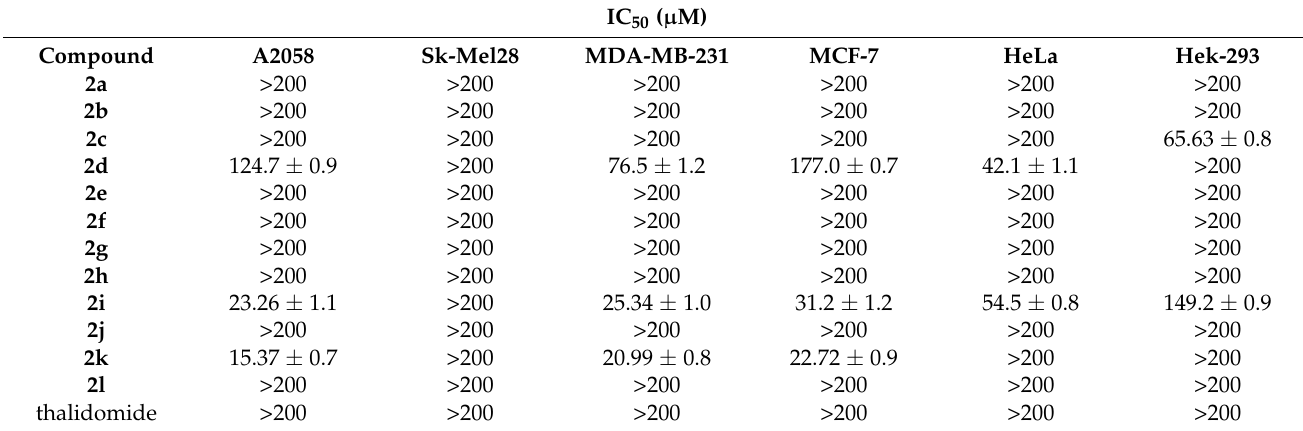
Table 1. IC 50 values of compounds 2a – l and thalidomide expressed in µ